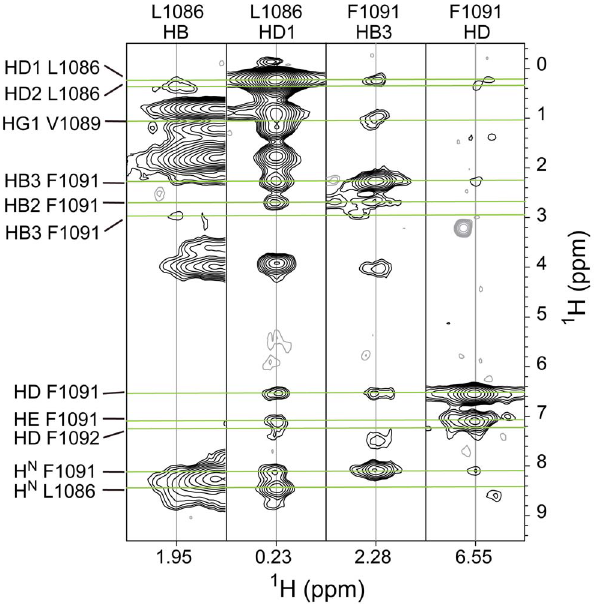
Figure 2. NOE connectivity in the IMC region of a L TM. Four selected strips from 15 N-NOESY-HSQC and 13 C-NOESY-HSQC show some NOE contacts among Leu-1086, Val-1089, Phe-1091, and Phe-1092.